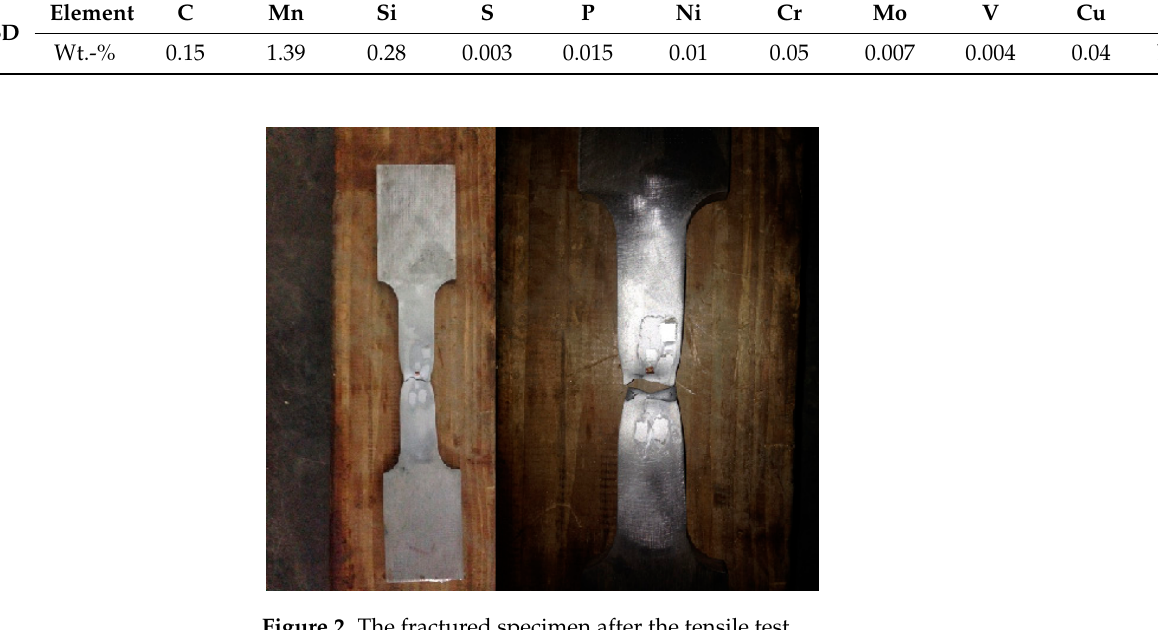
Table 1. Chemical compositions of Q345D steel.